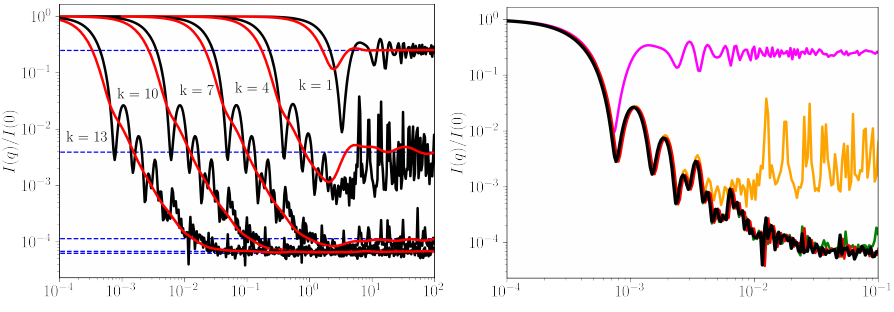
Figure 8. SAS from E. coli at pixelation levels k = 1,4,7 and 13. ( Left (Black) Monodisperse intensity (Equation (5). (Red) Polydisperse (smoothed) intensity (Equation (7)). (Dashed blue) asymptotic values at high q . Curves for k < 13 are shifted horizontally for better visualization). ( Right ) The same curves but not shifted. (Pink) k = 1. (Orange) k = 4. (Green) k = 7. (Red) k = 10. (Black) k =